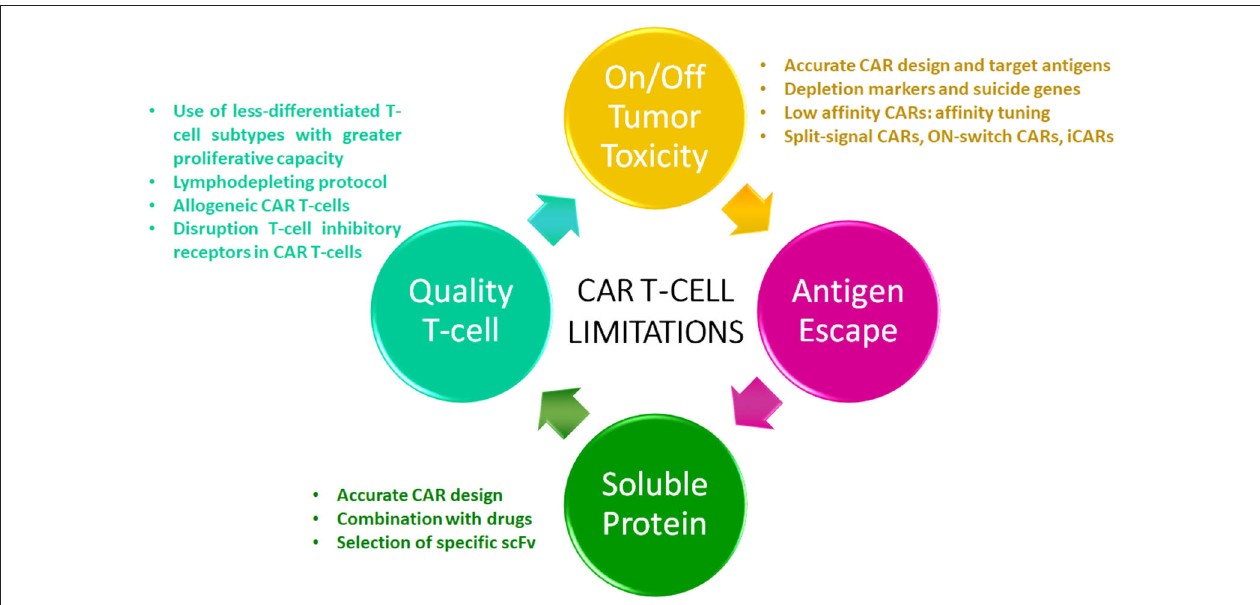
FIGURE 1 | CAR T-cell limitations. The diagram shows the current limitations of this therapeutic modality in multiple myeloma. Strategies to overcome these limitations are